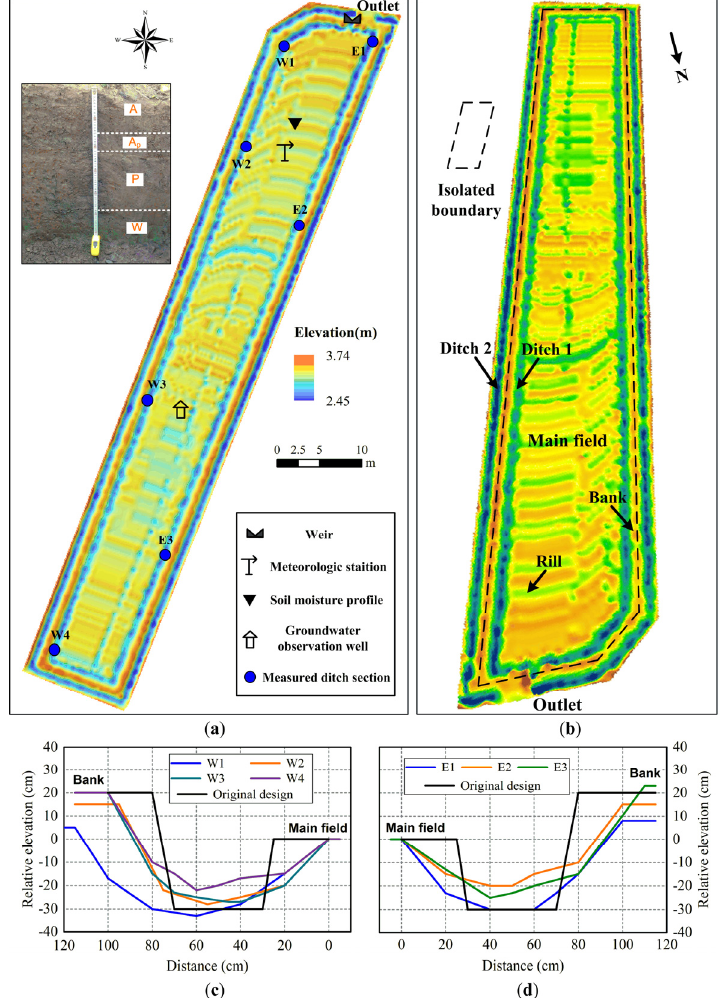
Figure 2. ( a ) Topography (0.1 m − resolution DEM) and layout of the experimental field; ( b ) three − dimensional view of the isolated catchment; ( c ) section shape of western ditch; ( d ) section shape of eastern ditch.